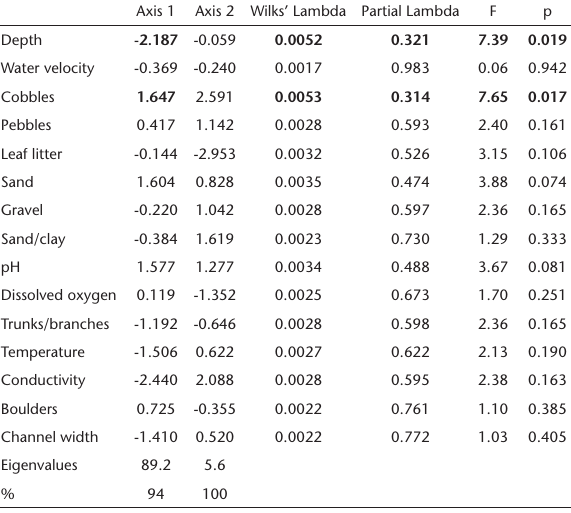
Figure 3. Scatter plot of sampling sites and mesohabitats in the Ver- melho River, Paraná state, Brazil, along the environmental gradient produced by the first two PCA axes (PC1 and PC2). Inner figure shows Pearson correlations of variables with PC1. Table 2. Results of discriminant analysis with environmental variables that contributed to separation of groups of mesohabitats (i.e., riffles, pools and runs) in the middle reach of the Vermelho River. Bold values are significant (p<0.05).